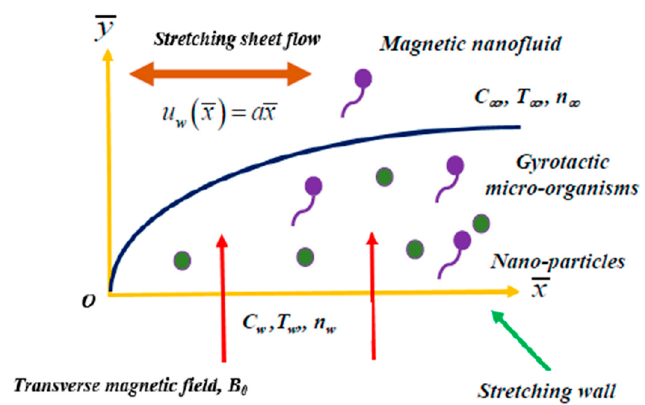
Figure 1. Physical configuration and coordinate system [48,51].